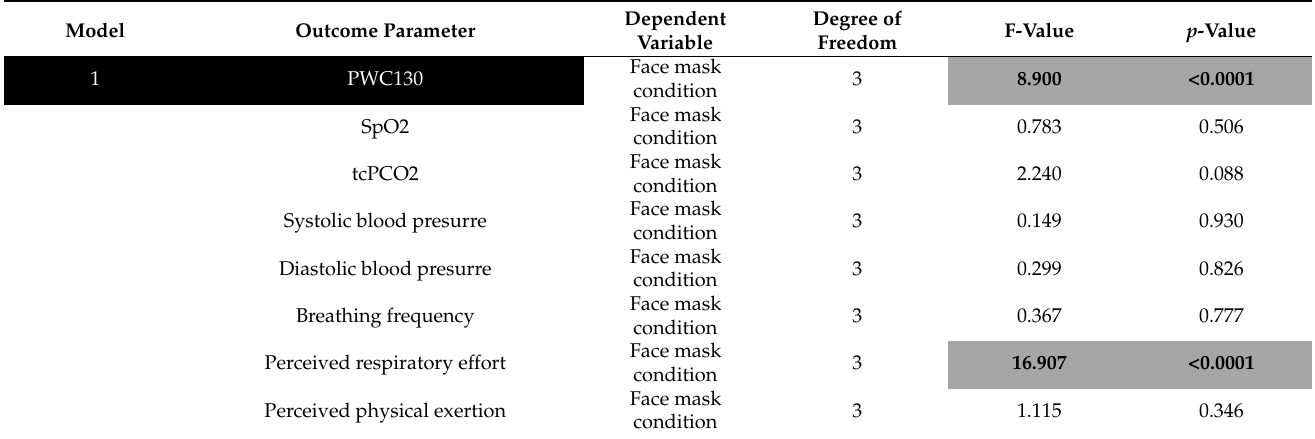
Table A4. Comparison between all face mask conditions—linear mixed model